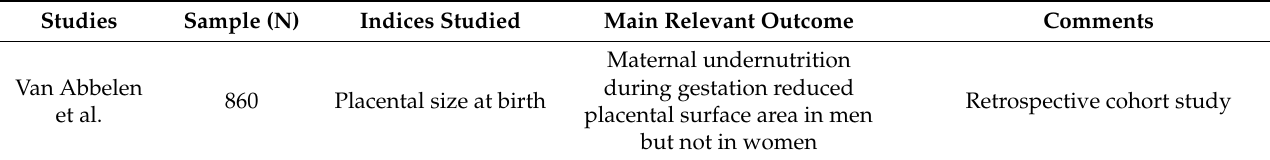
Table 5. Studies supporting the presence of gender-specific effects of maternal nutritional status during gestation, on placental size and surface